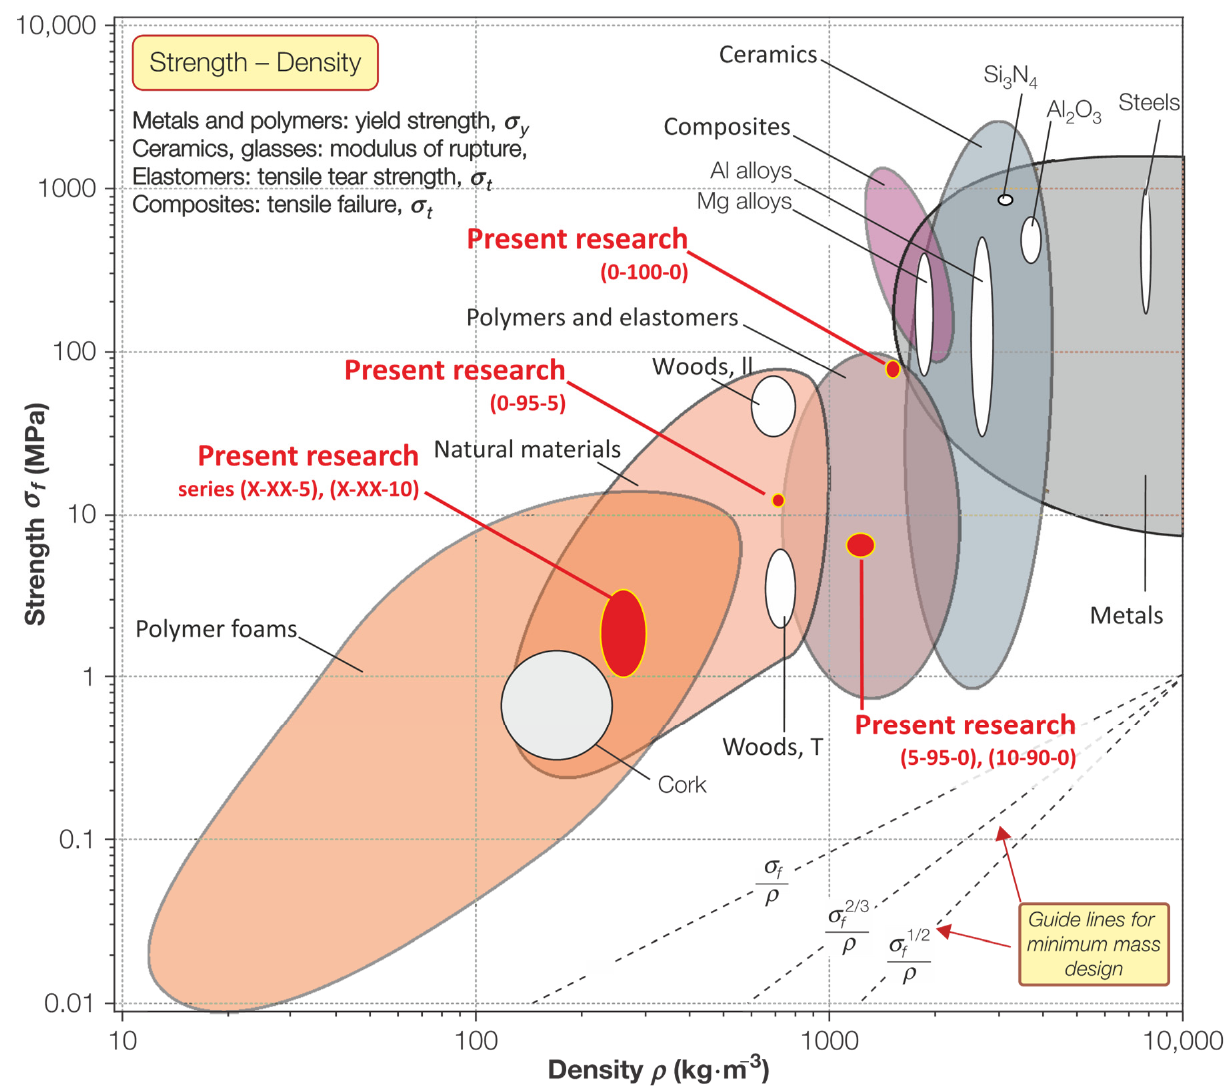
Figure 9. Influence on the compliance of studied biocomposites (in the form of a block) with typical materials demonstrated in the Ashby classification diagram (adapted from [38]).